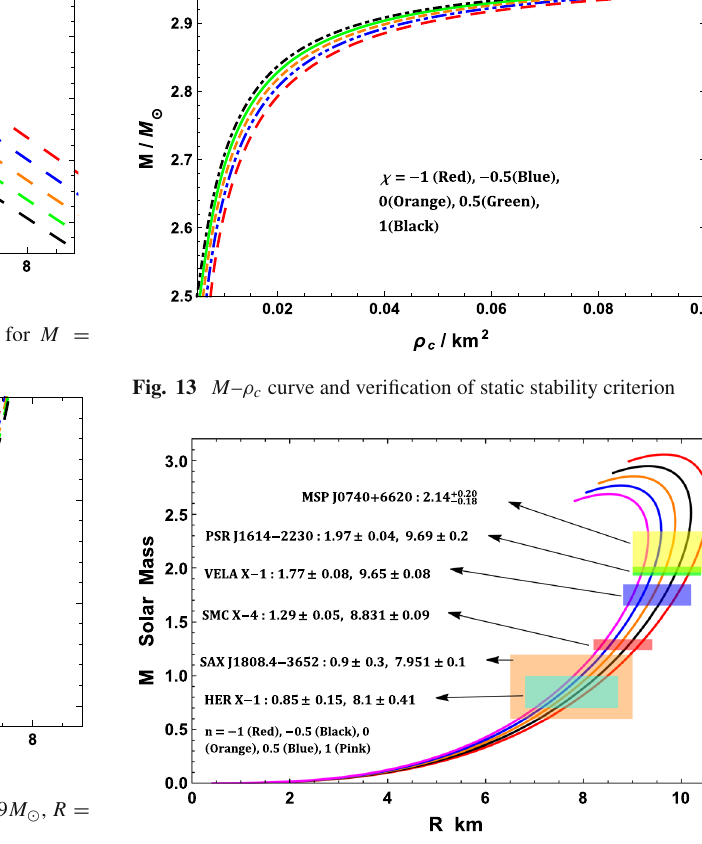
Fig. 14 M – R curve fitted with observed masses and estimation the radii for different values of χ – The beauty of this new solution is not only the embed- ding class one solution in f ( R , T ) -gravity but also in its M − R curve (Fig. 14). The M − R curve gener- ated from this solution can accommodate a variety of compact stars from the less massive (Her X-1) to super massive (MSP J0740+6620). In Table 1 we have